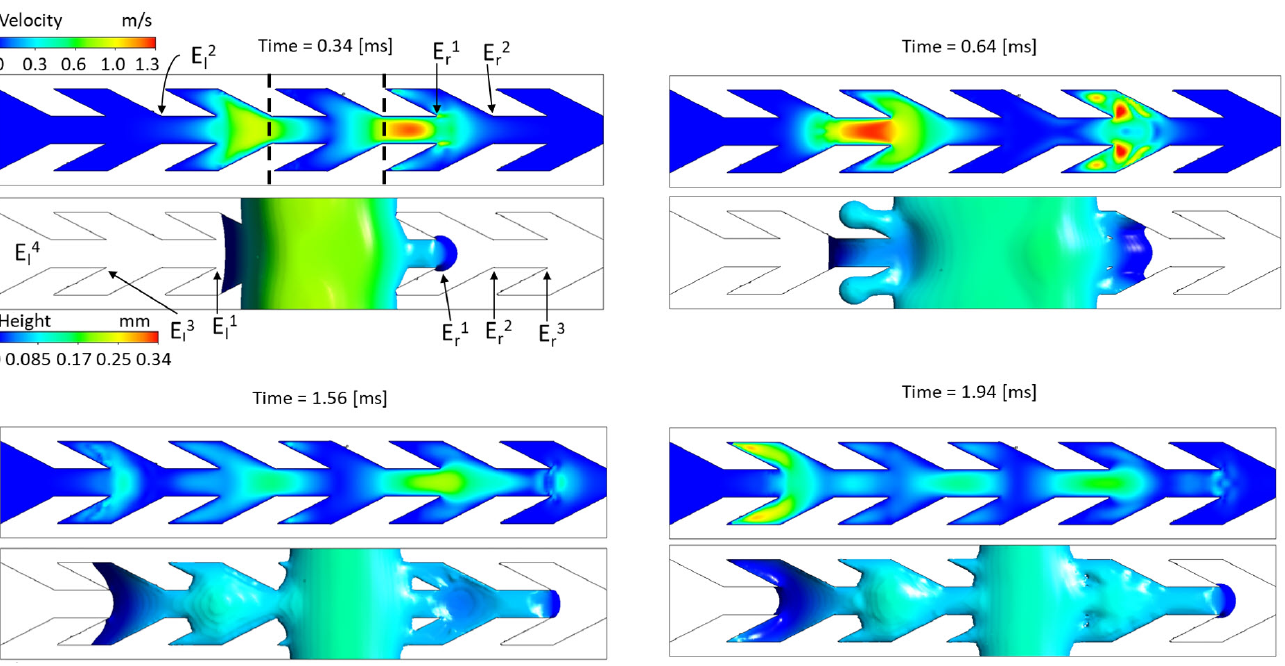
Figure 12. Simulated liquid velocity and free surface height during the wicking of a parallelepiped of liquid over a single fin shaped channel. For each sub-figure, the color scale displays the norm of the velocity field in the upper panel and the liquid height distribution for the bottom panel. Contact angle is 50 ◦ . The simulation domain consists of 6 elementary cells. The initial liquid parallelepiped is one elementary cell long. Figure credit from [37] Figure